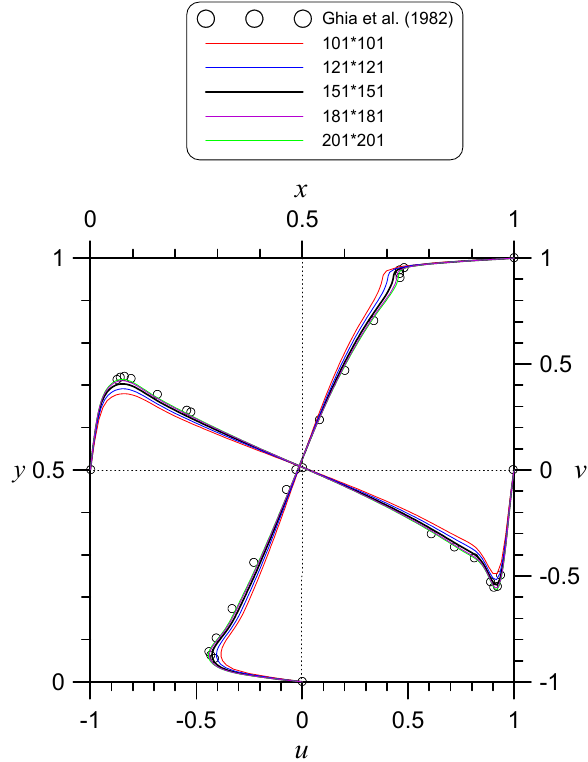
= 5000. Figure 7. Computed steady velocity profiles for Re lid = lid